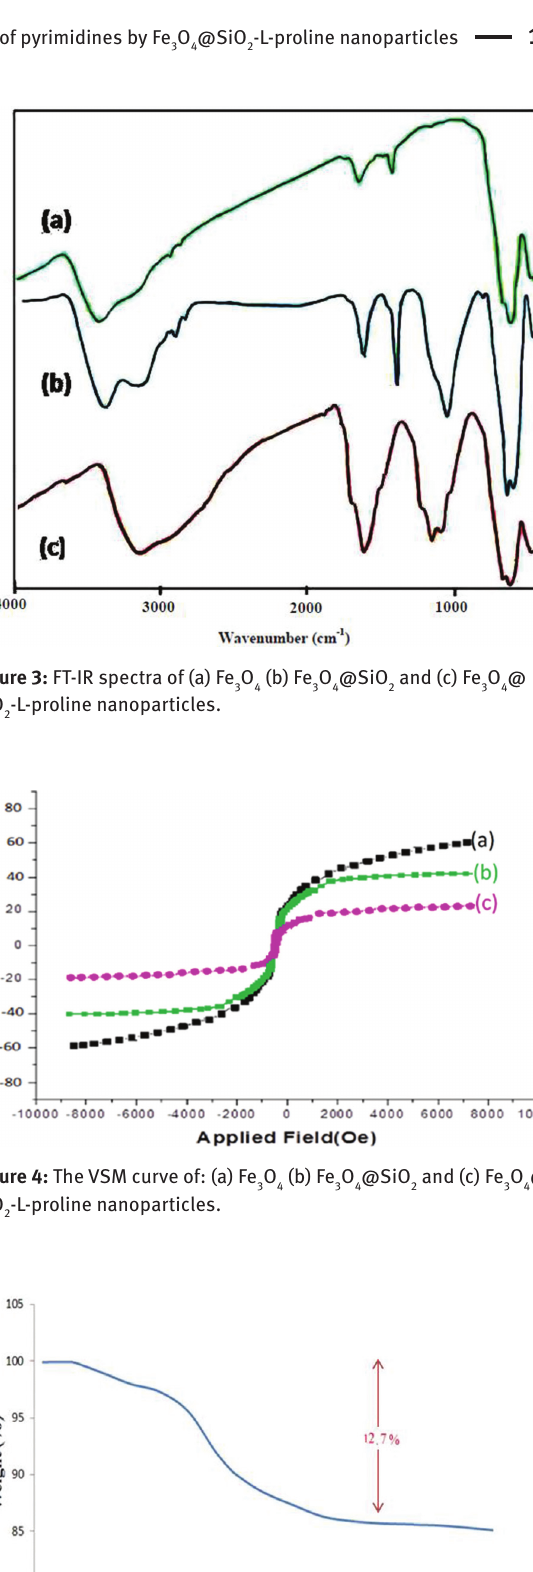
O @SiO -L-proline nanoparticles. 3 4 2